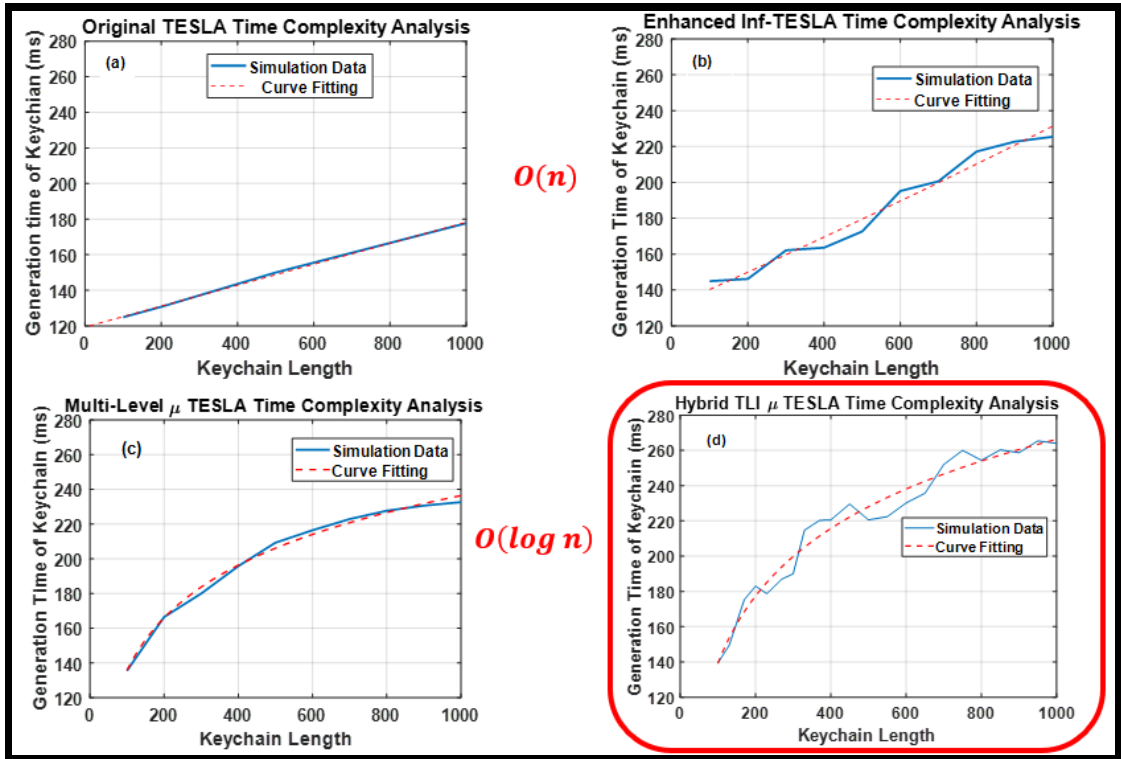
Figure 5. Time complexity analysis of ( a ) Original TESLA, ( b ) Enhanced Inf-TESLA, ( c ) Multilevel- µTESLA, and ( d ) Proposed Hybrid TLI-µTESLA protocols.